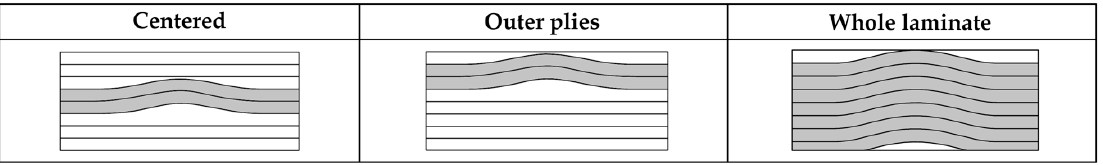
Figure 34. Portion and position of the wavy layers in the laminate.